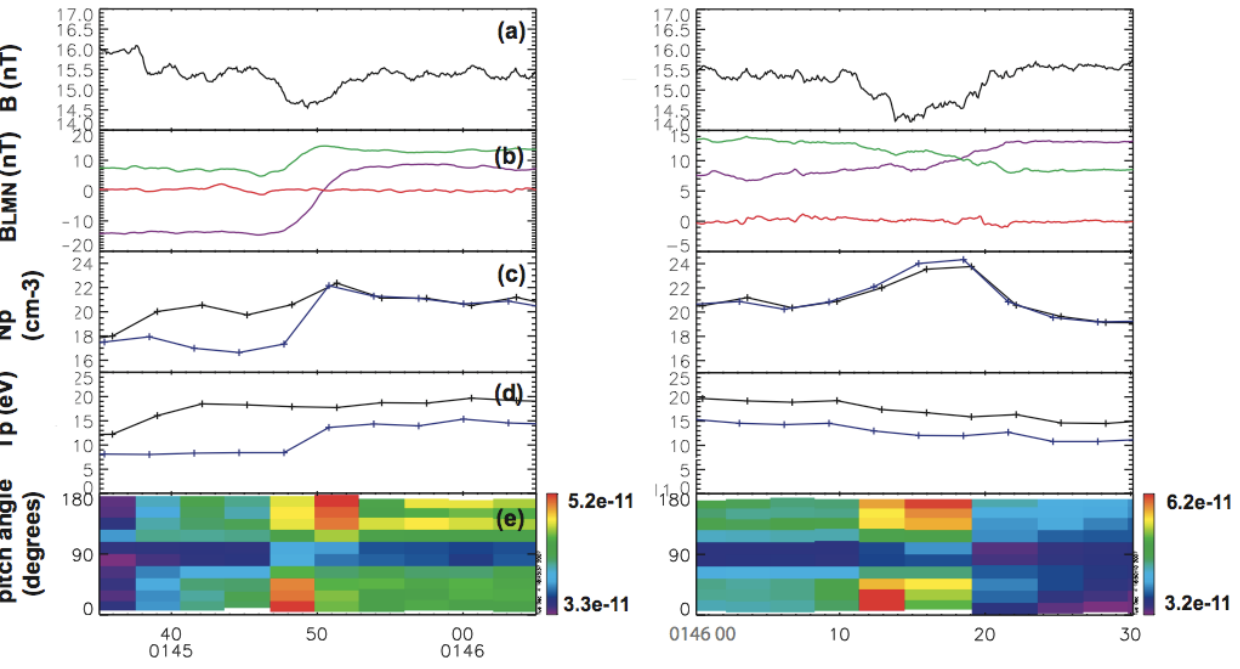
Fig. 6. Close-up around the separatrix regions at the front (left panel) and end (right panel) boundaries of the reconnection exhaust. The panels show from top to bottom: (a) the magnetic field strength, (b) the magnetic field components in the MVA coordinate system, (c) the proton density calculated on-board (blue line) and the one integrated from the 3-D distribution functions (black line), (d) the “on-board” proton temperature (blue line) and the proton temperature integrated from the 3-D distribution functions (black line), and (e) the pitch angle spectrogram of 27eV electrons. The color coding indicates the amplitude of the distribution functions in units of s 3 km − 3 cm − 3